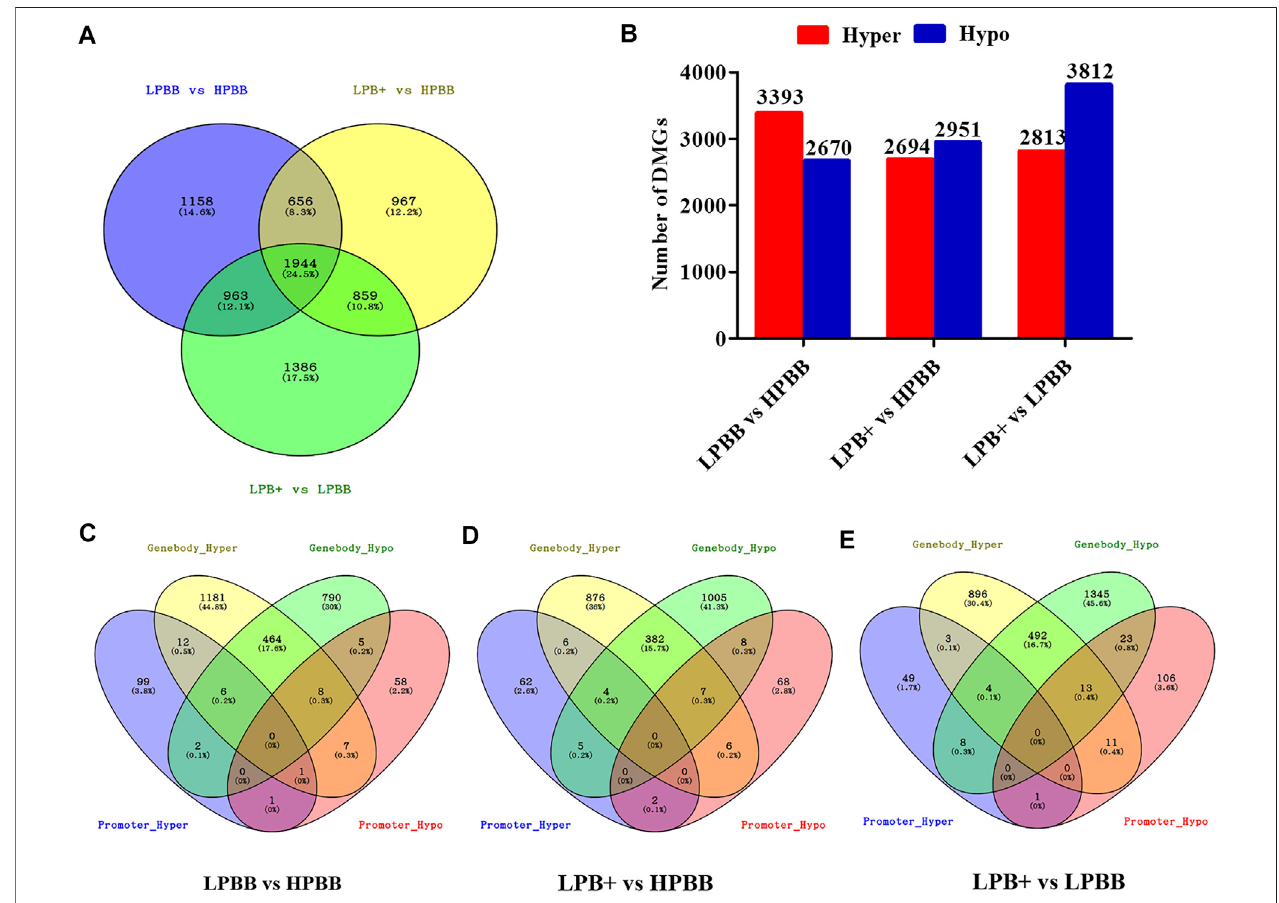
FIGURE 3 | DMGs in the ovaries of different comparison groups. (A) DMGs that were unique or common among different comparison groups. (B) Number of hyper-andhypo-methylatedgenesindifferentcomparisongroups. (C – E) VenndiagramofthenumberofDMGsinpromoterandgenebodyintheLPBBvs.HPBB,LPB + vs. HPBB, and LPB + vs. LPBB